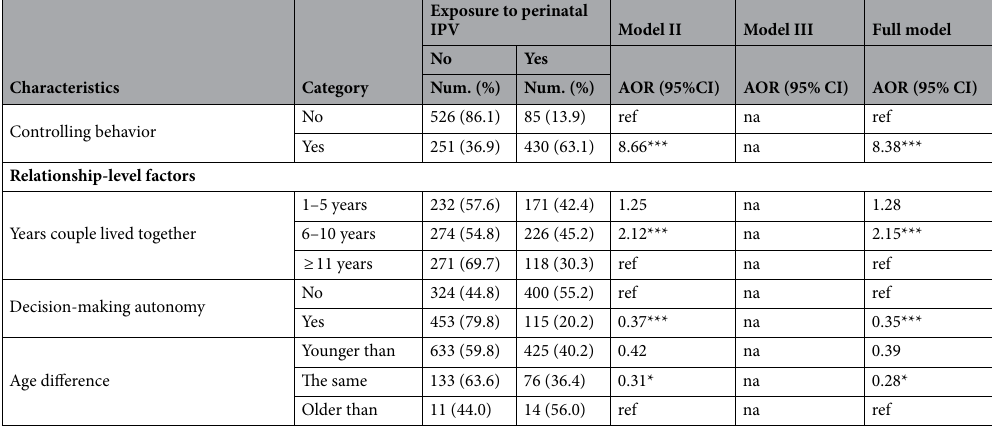
Table 3. Multilevel logistic regression models for individual-, relationship-, and community-level factors associated with self-reported perinatal partner violence in Wolaita Zone (n = 1292). Statistically significant